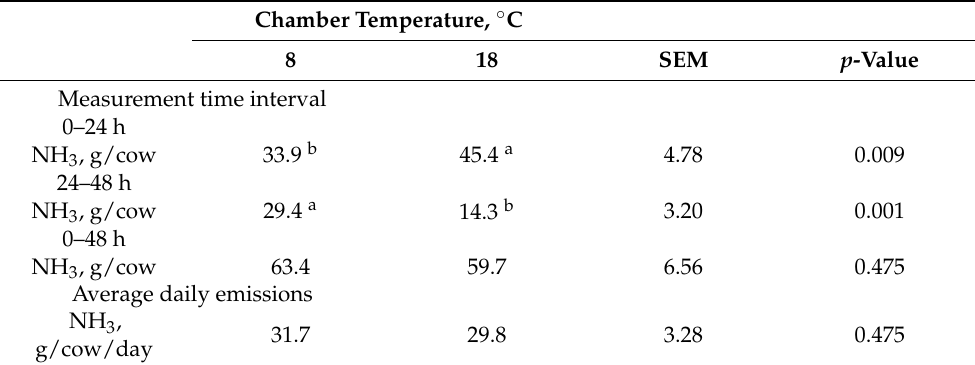
Table 4. Effect of chamber temperature on NH 3 emissions from slurry from lactating cows by measurement time